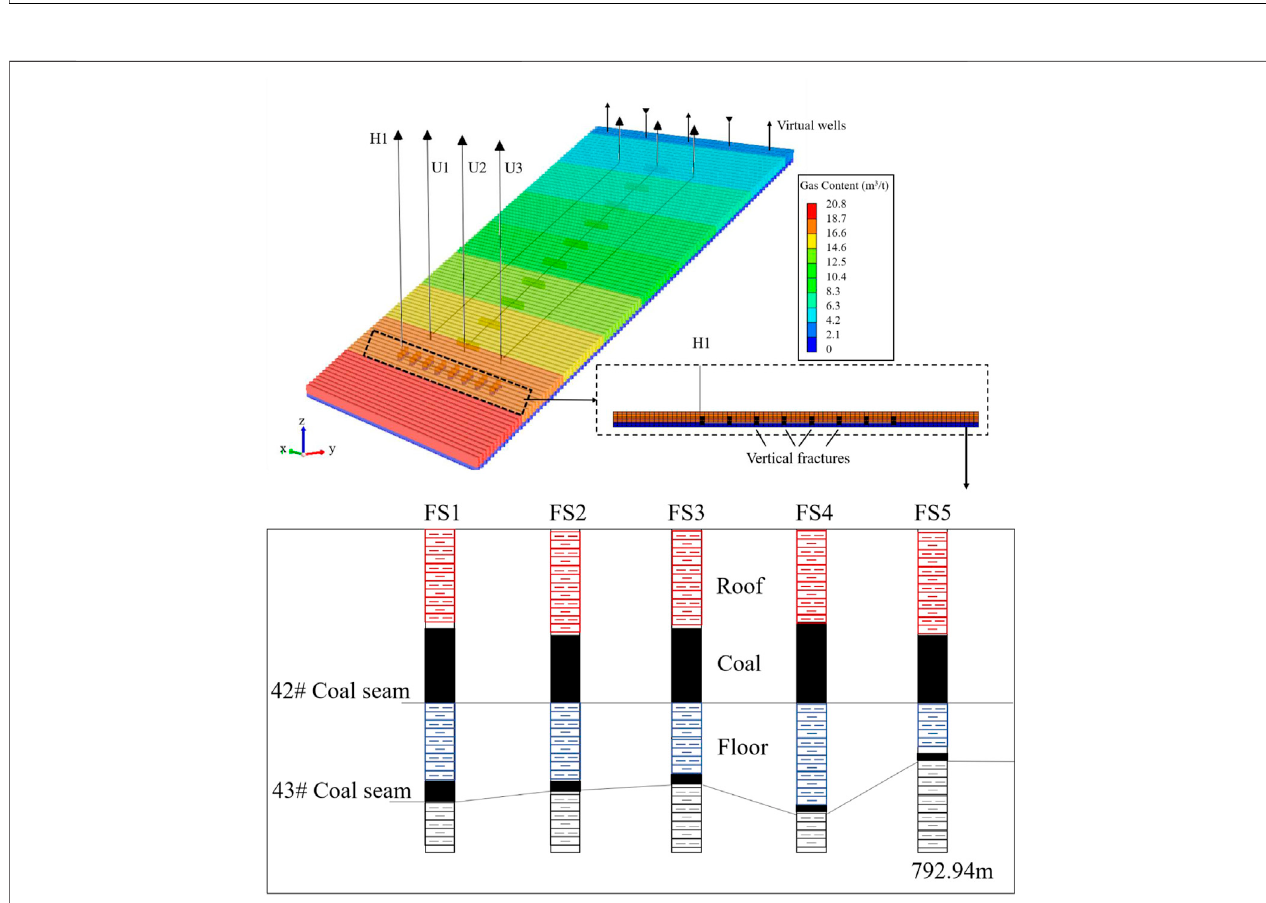
Frontiers in Earth Science |